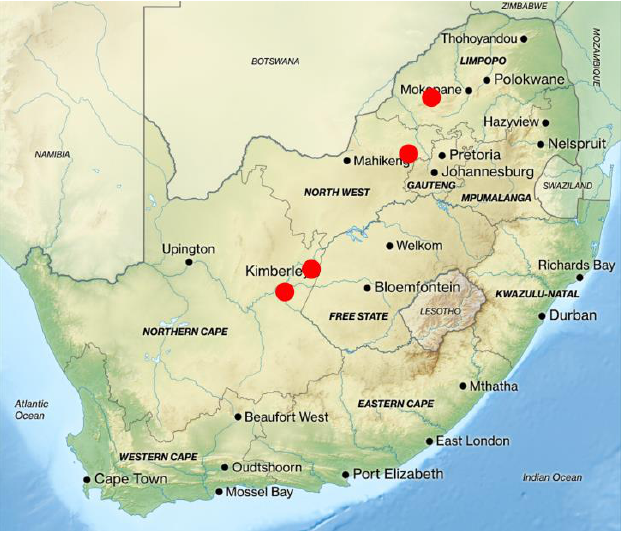
Figure 1. Map of South Africa indicating the sampling sites of buffaloes on private game reserves (red dots).